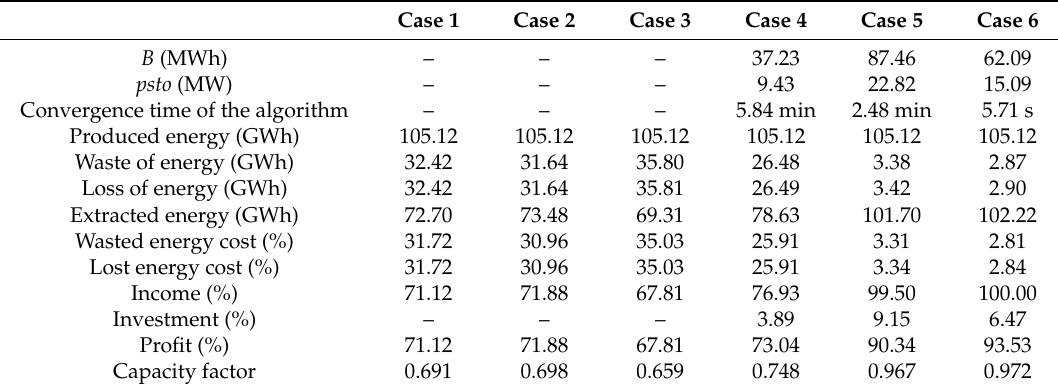
Table 1. Summary of results in a year for different cases.